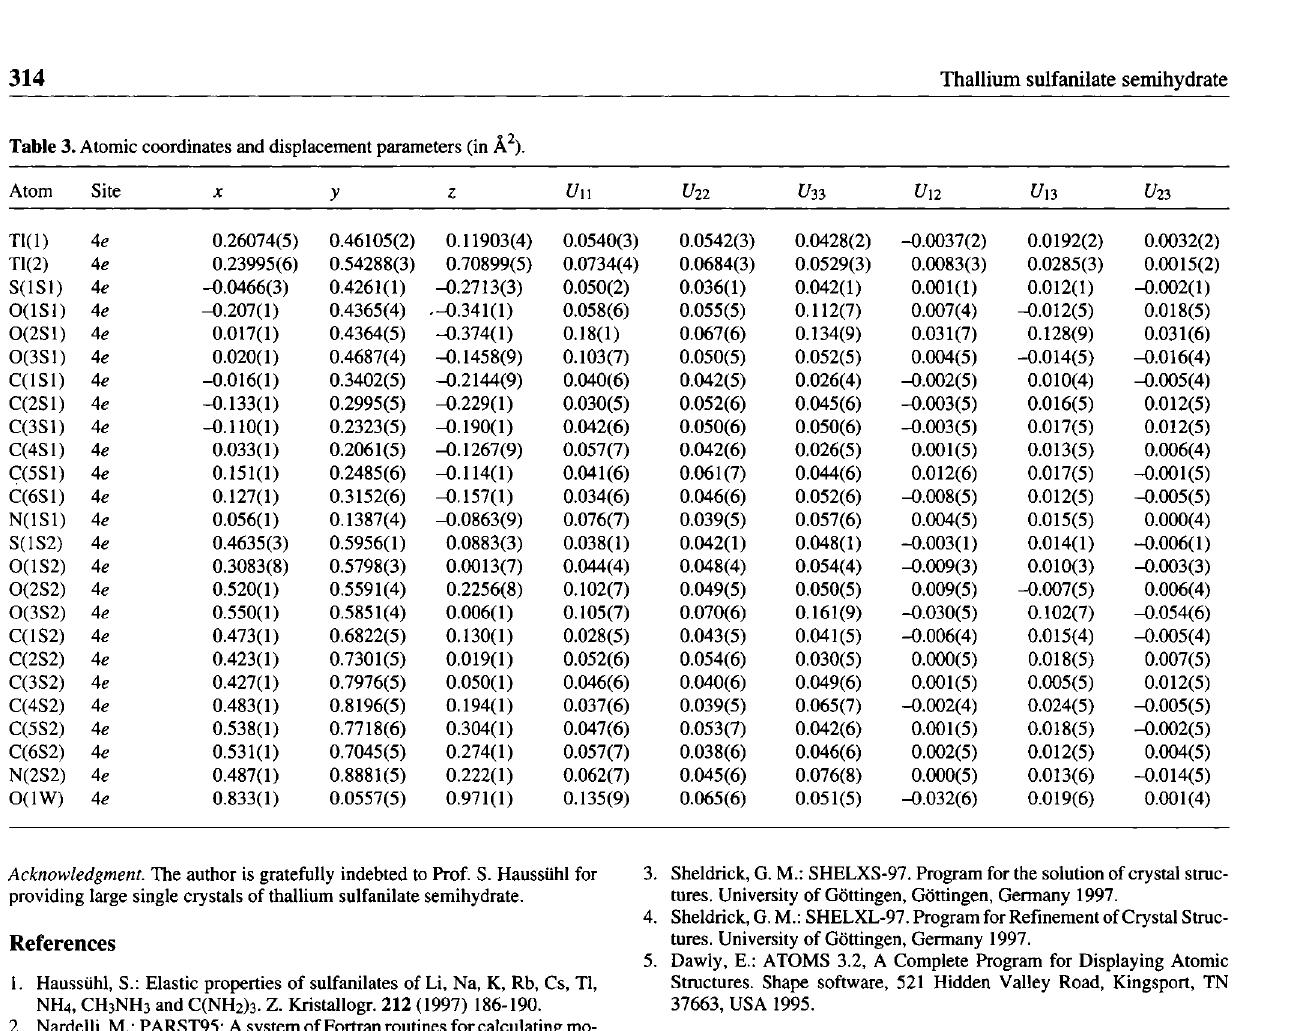
Table 3. Atomic coordinates and displacement parameters (in Â 2